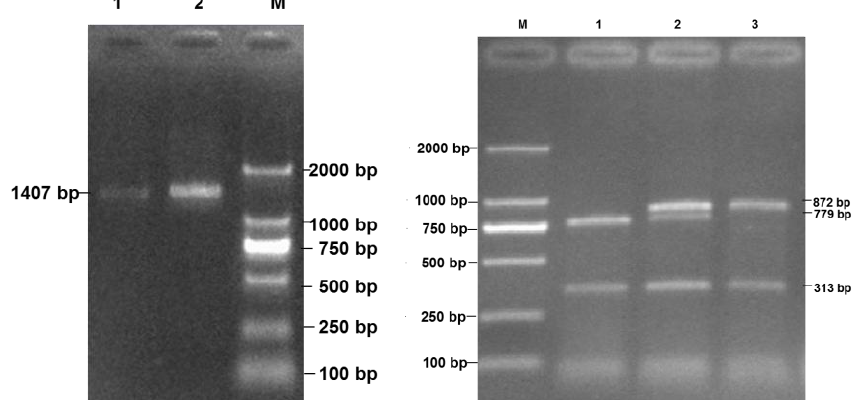
Figure 2. Electrophoresis pattern of the Stu I locus within the pig TMEM95 gene.